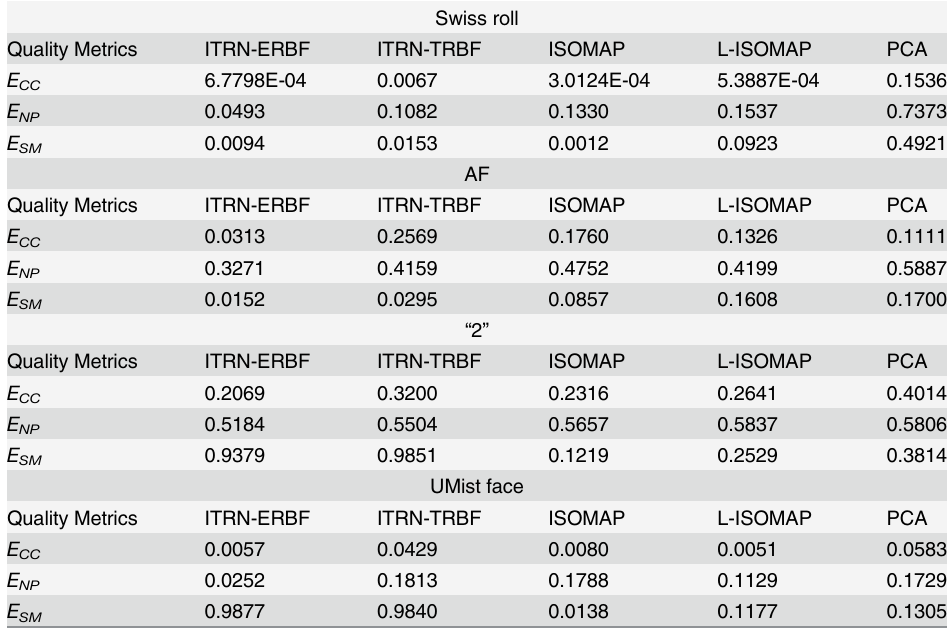
Table 2. Values of quality metrics for ITRN-RBF and classical dimensionality reduction methods. Swiss roll